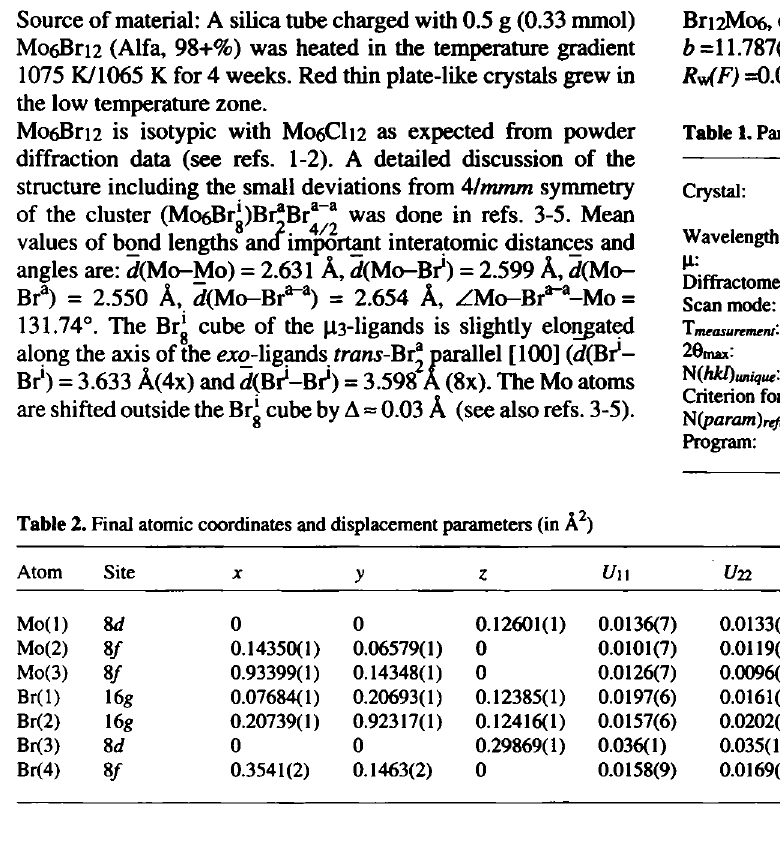
Table 2. Final atomic coordinates and displacement parameters (in Â^)